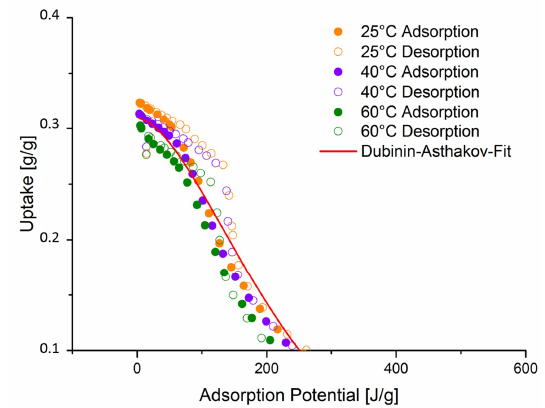
Figure 2. Plot of the water sorption isotherms of silica gel at different temperatures during ad- and desorption. The red line depicts the adapted Dubinin-Asthakov-Fit; data points and fits for other materials are provided in the Supplementary